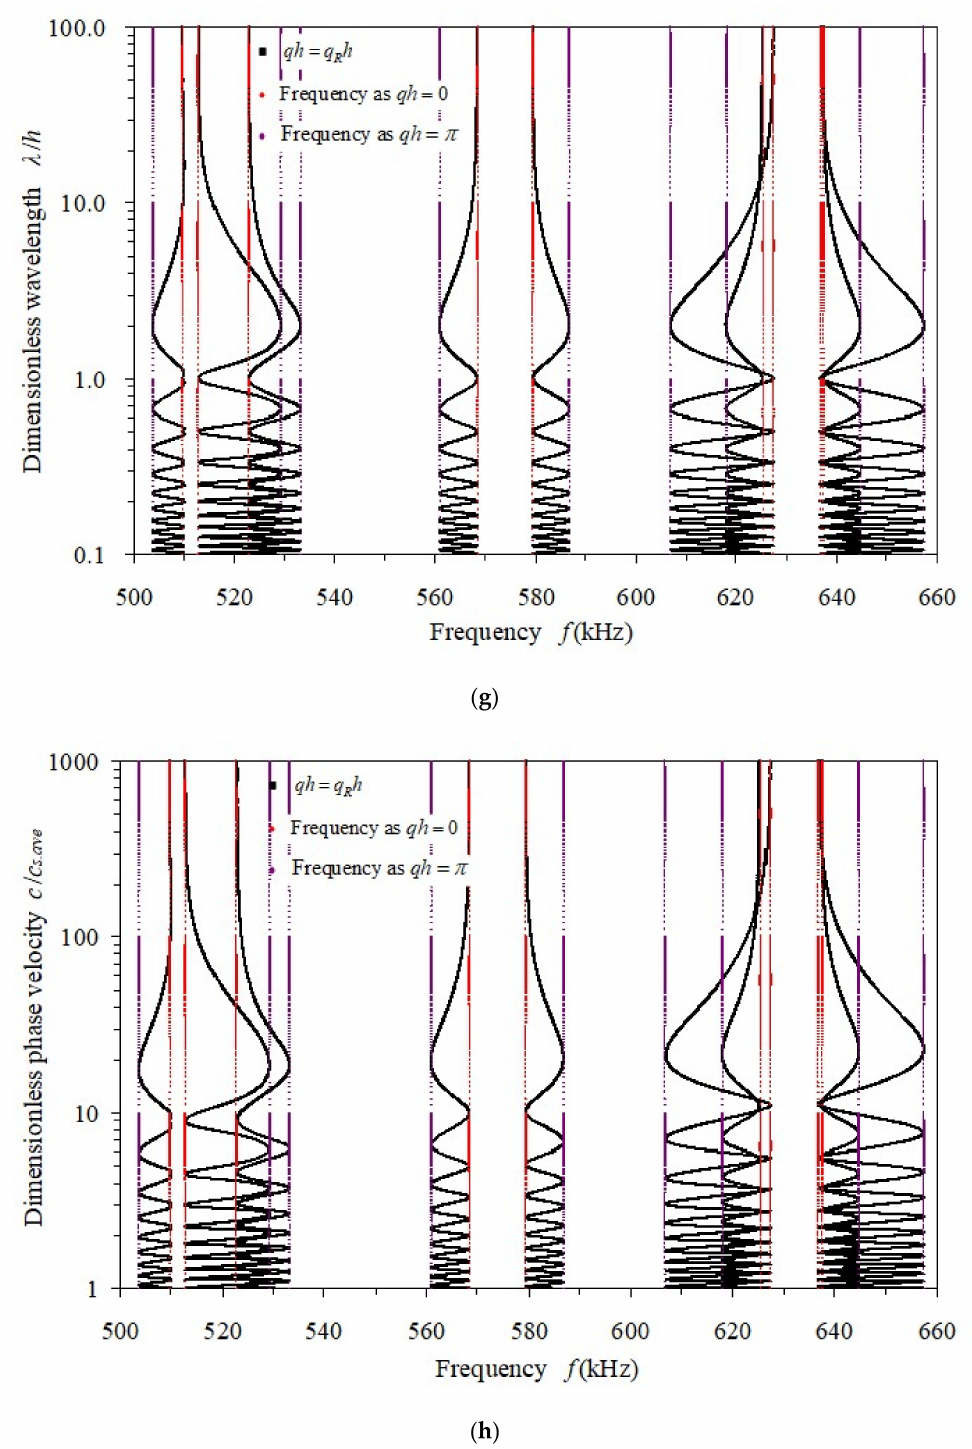
Figure 8. The comprehensive dispersion curves of Floquet in–plane waves propagating obliquely to layering in the exemplified periodically bi–layered media. The frequency–related dispersion curves in low frequency range: ( a ) the frequency–wavenumber spectra, ( b ) the frequency–wavelength spectra, and ( c ) the frequency–phase velocity spectra. The other phase velocity-related dispersion curves: ( d ) the wavenumber–phase velocity curves, ( e ) the wavelength–phase velocity curves. The frequency–related dispersion curves within high frequency ranges: ( f ) the frequency–wavenumber spectra, ( g ) the frequency–wavelength spectra, and ( h ) the frequency–phase velocity